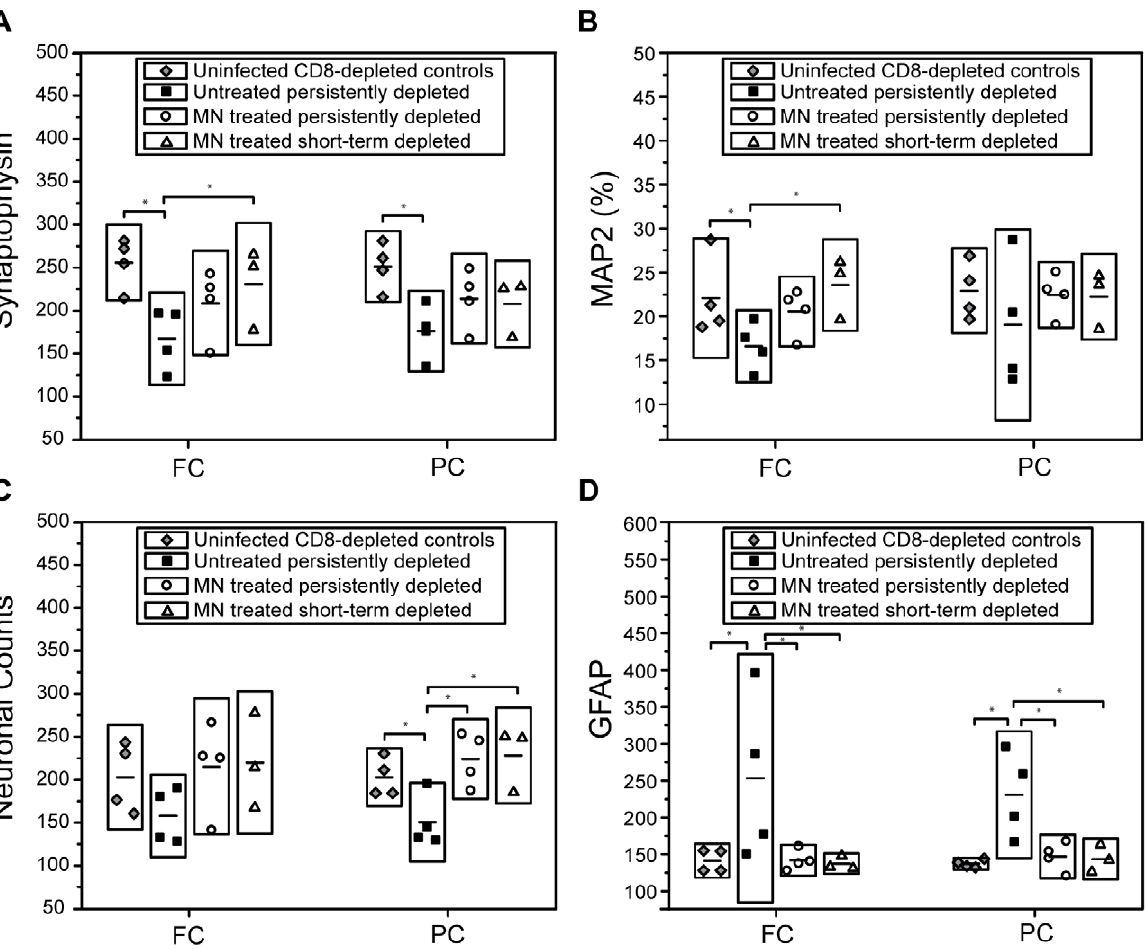
Figure 6. Minocycline preserves neuronal integrity and decreases astrogliosis. Synaptophysin (SYN), Microtubule-associated protein 2 (MAP2), neuronal counts, and glial fibrillary acetic protein (GFAP) levels were quantified in the frontal and parietal cortices of 1) four uninfected CD8- depleted control animals, 2) four SIV-infected, persistently CD8-depleted untreated animals, 3) four MN-treated, SIV-infected, persistently CD8- depleted animals and 4) three MN-treated, SIV-infected, short-term CD8-depleted animals. Horizontalbarswithinboxesrepresentmeanvalues; heightofeachboxcorrespondstoafactorof1.5timesstandarddeviation.*indicatesasignificantdifference(p # 0.05)betweengroups. ( A ) Frontal cortex SYN levels were decreased in SIV-infected CD8-depleted untreated animals versus uninfected CD8-depleted controls (p=0.007). Synaptophysin was higher in MN-treated short-term depleted animals compared to untreated animals (p=0.05). No statistical differences between controls and either of the two MN-treated cohorts were observed. Parietal cortex SYN levels were also decreased in SIV-infected CD8-depleted untreated animals versus controls (p=0.006). ( B ) MAP2 levels were decreased in SIV-infected CD8-depleted untreated animals versus controls (p=0.046) and versus MN-treated, short-term CD8-depleted animals (p=0.02). Parietal cortex MAP2 levels were higher in controls and MN-treated animals compared to untreated animals; however, these differences fail to yield statistical significance. ( C ) In the parietal cortex SIV-infected untreated animals had lower neuronal counts compared to controls (p=0.031). There were decreased numbers of neurons in untreated animals compared to both the MN-treated persistently CD8-depleted animals (p=0.005) and short-term CD8-depleted animals (p=0.006). ( D ) Frontal cortex GFAP levels were increased in the SIV-infected, CD8-depleted untreated cohort compared to uninfected CD8-depleted controls (p=0.023). GFAP levels in both MN-treated persistently CD8-depleted animals (p=0.023) and short-term CD8-depleted animals (p=0.027) were significantly decreased compared to the untreated cohort. Increases in parietal cortex GFAP levels were identified in the SIV-infected, CD8-depleted untreated cohort compared to uninfected controls (p=0.002). GFAP levels in both MN-treated persistently CD8-depleted animals (p=0.0041) and short-term CD8- depleted animals (p=0.0026) were significantly decreased compared to the untreated cohort. doi:10.1371/journal.pone.0010523.g006 (Figure 6D, ANOVA p =0.05 and ANOVA p= 0.0062, (ANOVA p=0.017) showing decreased numbers of neurons in respectively). GFAP was significantly elevated in the frontal and untreated animals compared to both the MN-treated persistently parietal cortices of the SIV-infected, CD8 + cell-depleted animals CD8-depleted animals and short-term CD8-depleted animals. when compared to the uninfected, CD8-depleted control animals GFAP – marker of astrogliosis. Glial fibrillary acidic protein (GFAP) is the principal intermediate filament in mature and the two cohorts that were treated with MN. No statistical astrocytes. Astrocytes rapidly synthesize GFAP in response to a difference between the uninfected, CD8-depleted controls and neurologic insult, and it is the most commonly used marker of either of the two MN-treated cohorts was observed. astrogliosis. GFAP levels were quantified in the frontal and parietal IBA-1 – marker of microglial activation. Calcium binding cortex of the same four cohorts of animals used for the neuronal adaptor protein 1, IBA-1 is expressed by resting microglia and is marker determinations described in the previous section upregulated when these cells are activated [27]. Widespread